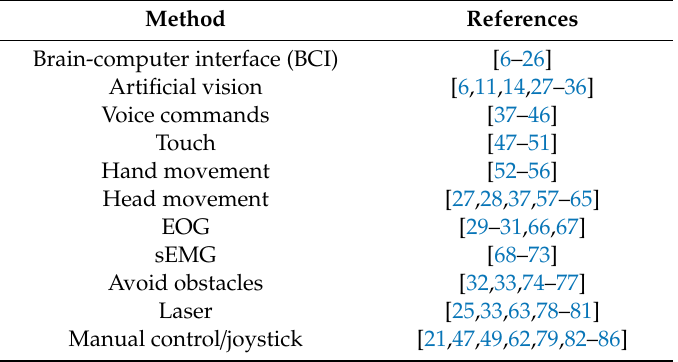
Table 1. Input methods of the controllers in the articles reviewed.